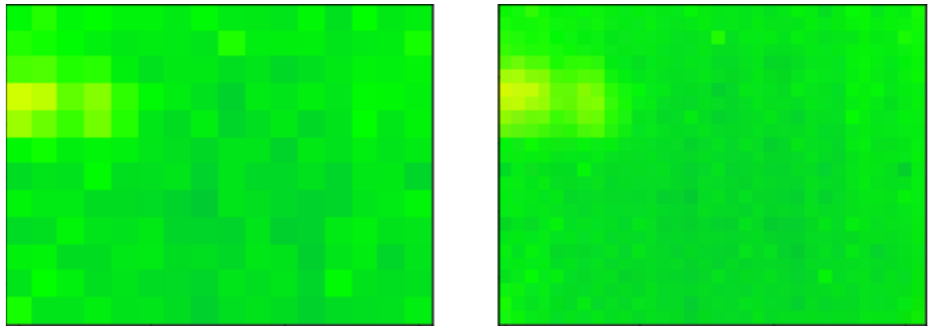
Figure 11. An example of a frame misclassified on its original size and correctly classified upon upscaling. The low-resolution frame ( left ) has been classified as if there is one person in the room. Upon upscaling the frame ( right ), the classifier managed to identify two different people in the